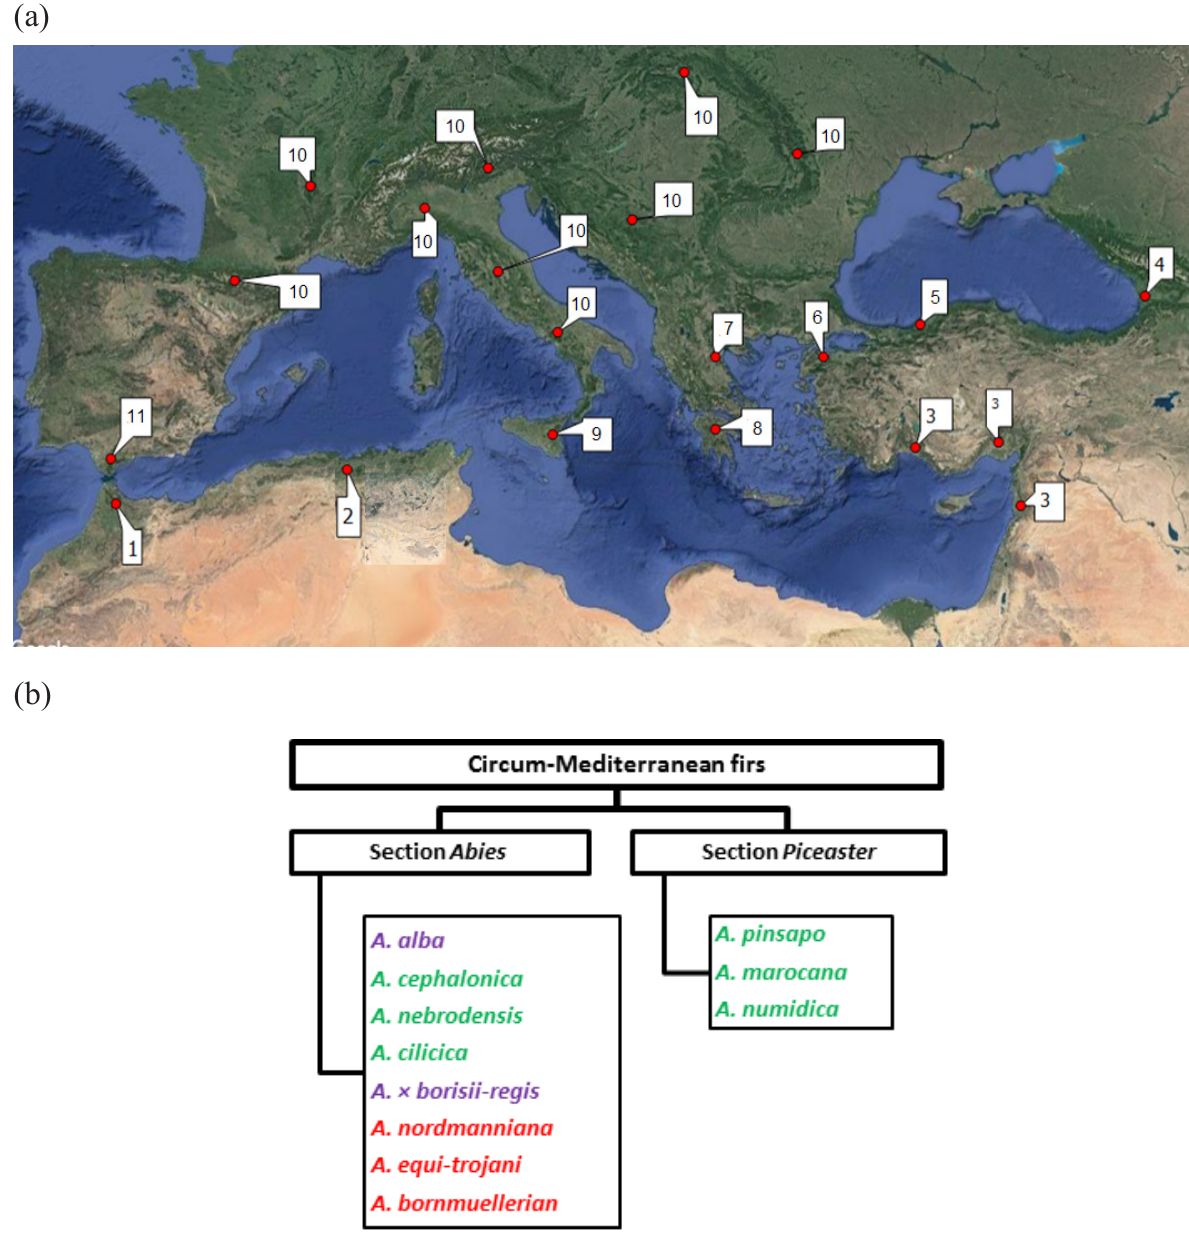
Figure 1. a, Distribution of circum-Mediterranean firs Abies ssp. 1: A. marocana ; 2: A. numidica ; 3: A. cilicica ; 4: A. nordmanniana, 5: A. bornmuellerian ; 6: A. equi-trojani ; 7: A. borisii-regis ; 8: A. cephalonica ; 9: A. nebrodensis ; 10: A. alba ; 11: A. pinsapo ; b, The two recognized sections within circum-Mediterranean firs and their Mediterranean character: strictly Mediterranean firs in green, sub-Mediterranean firs in purple and northern Anatolians firs in